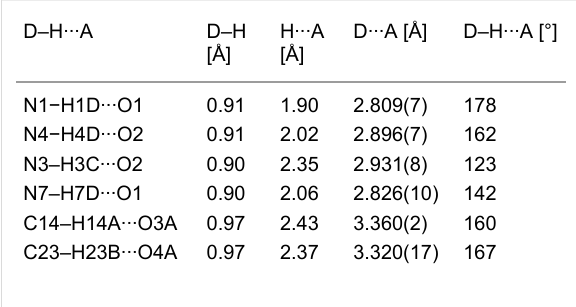
Table 6: Selected hydrogen-bond lengths (Å) and bond angles (°) of complex 2